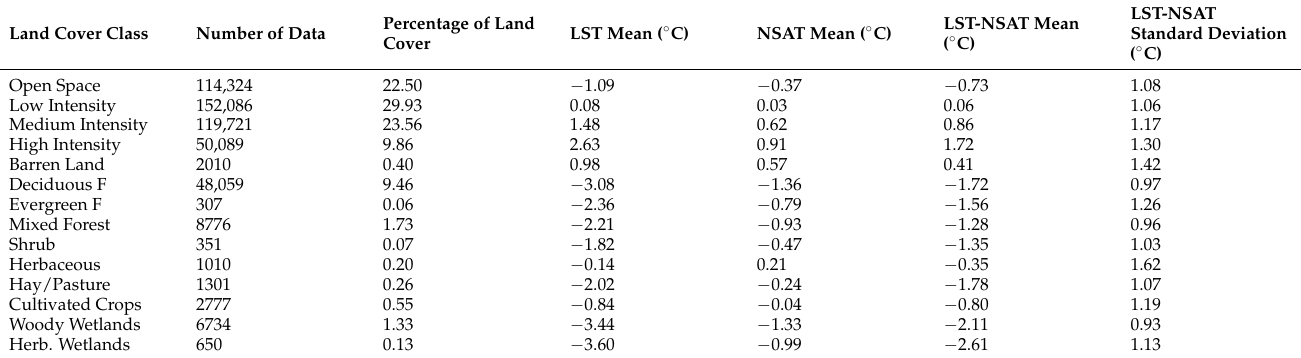
Table 4. Descriptive statistics for Washington,